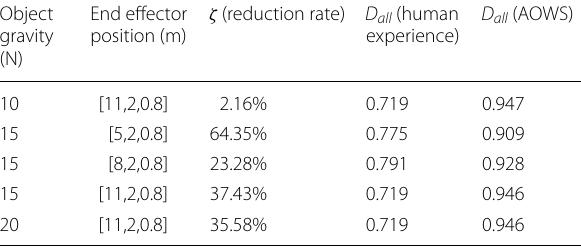
Table 3 Aows performance under different conditions Object gravity